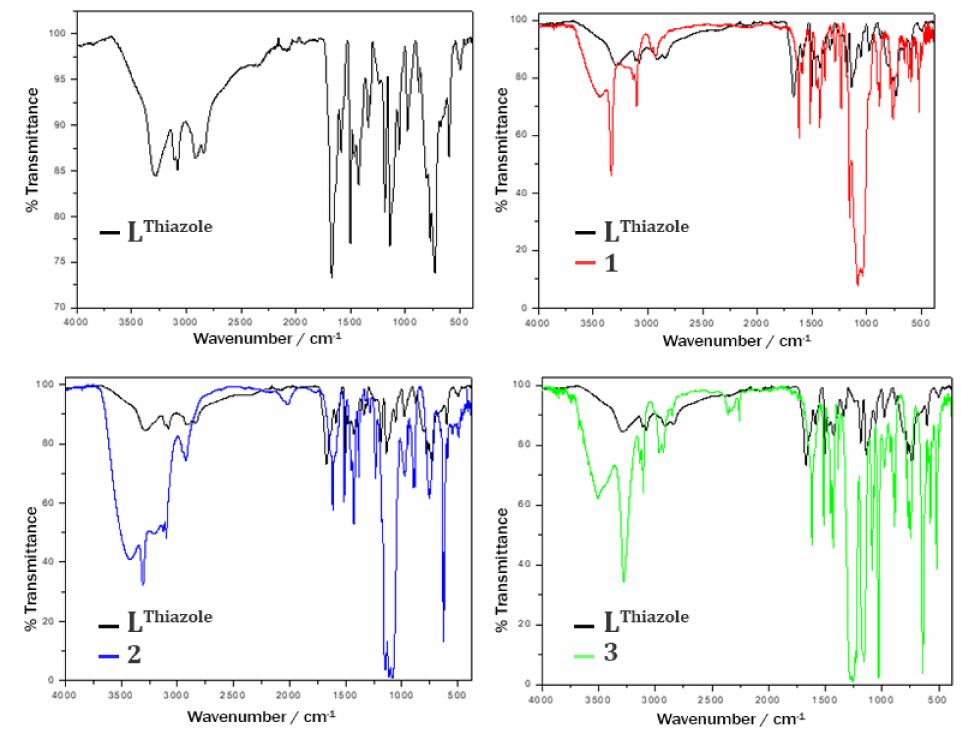
Figure 4. Comparison of IR spectra of L Thiazole (black, top left ) with 1 (red line, top right ), 2 (blue, bottom left ) and 3 (green, bottom right ). All complex spectra are overlaid onto the ligand spectra (black